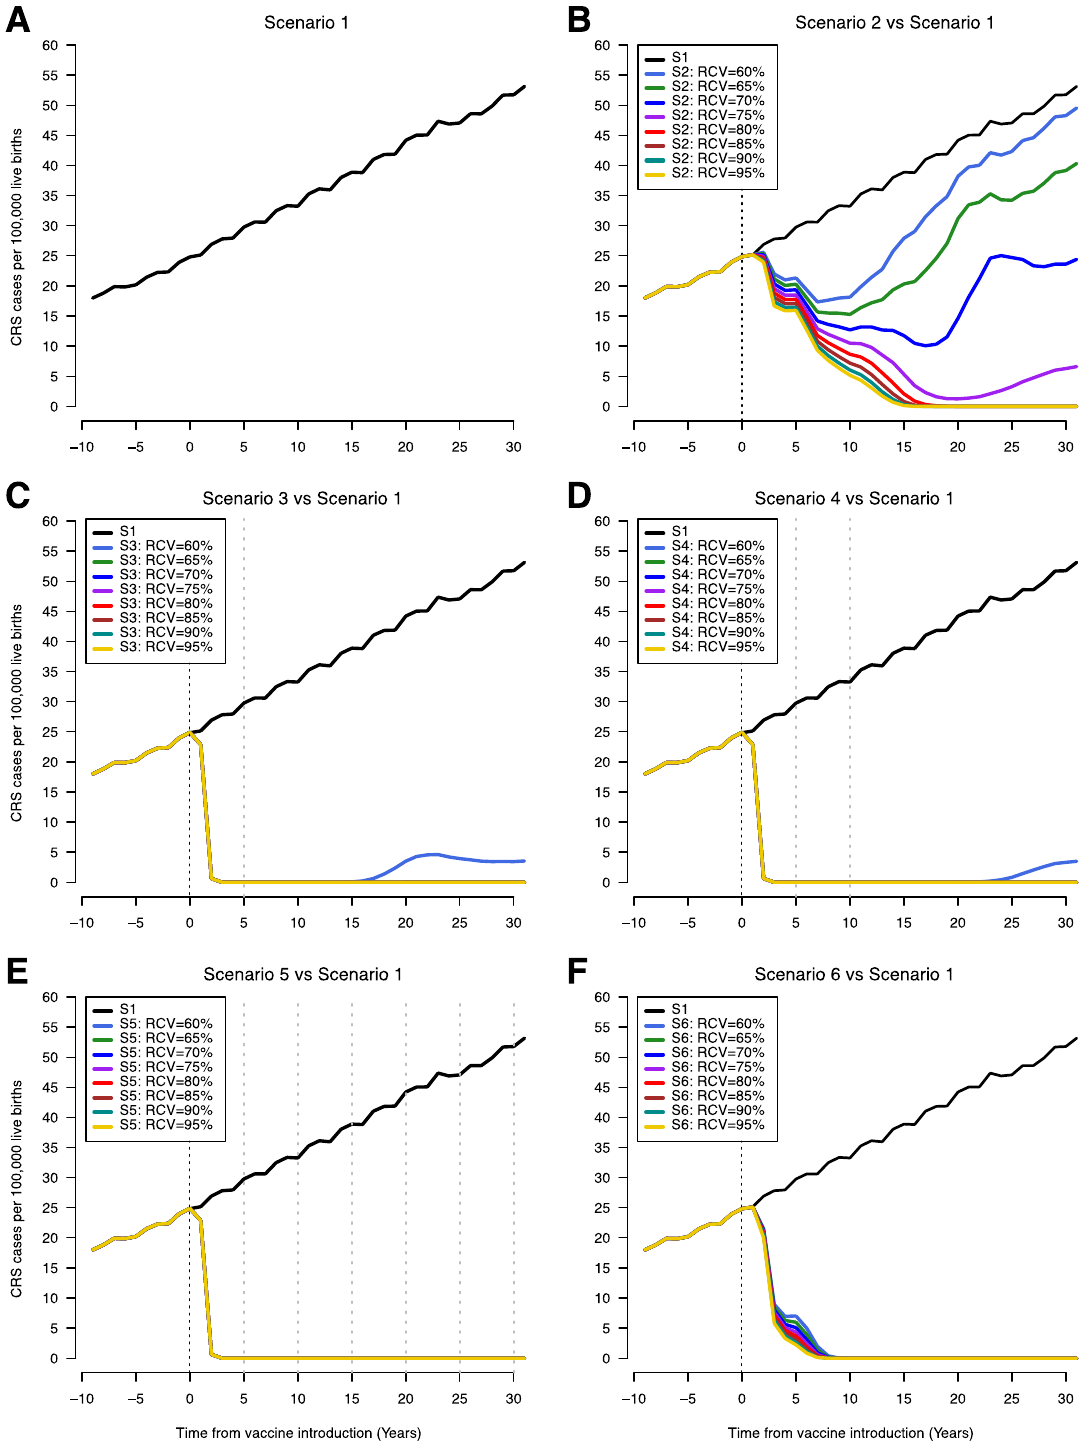
Figure 2. Time series of congenital rubella syndrome (CRS) incidence (CRS cases per 100,000 live births) showing scenario 1 ( A ) and comparing scenario 1 with scenarios 2–6 ( B – F ). The vertical black dotted line indicates year of RCV introduction (year zero) and the grey dotted lines represent SIAs. The x-axis shows time from 10 years prior to RCV introduction to 30 years after RCV introduction. CRS incidence estimates overlap on the plots for di ff erent RCV coverages, so that only the line for 95% coverage appears on the graph (RCV coverages 65–95% years 0–30 ( C and D ), RCV coverages 60-95% years 0–30 ( E ), and RCV coverages 60–95% years 8–30 ( F )) . (S1 = scenario 1, S2 = scenario 2, S3 = scenario 3, S4 = scenario 4, S5 = scenario 5, S6 = scenario 6).